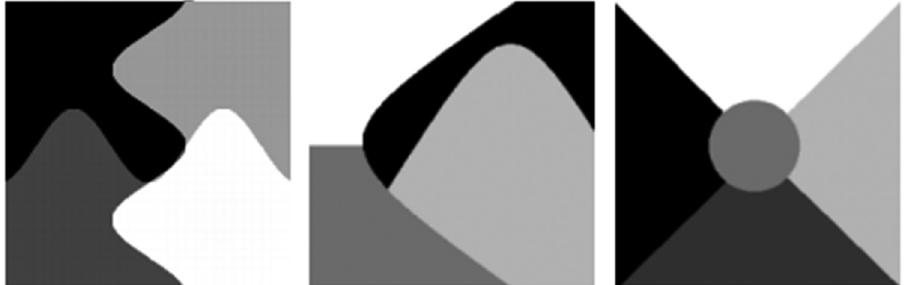
Figure 2: A basic SAR image